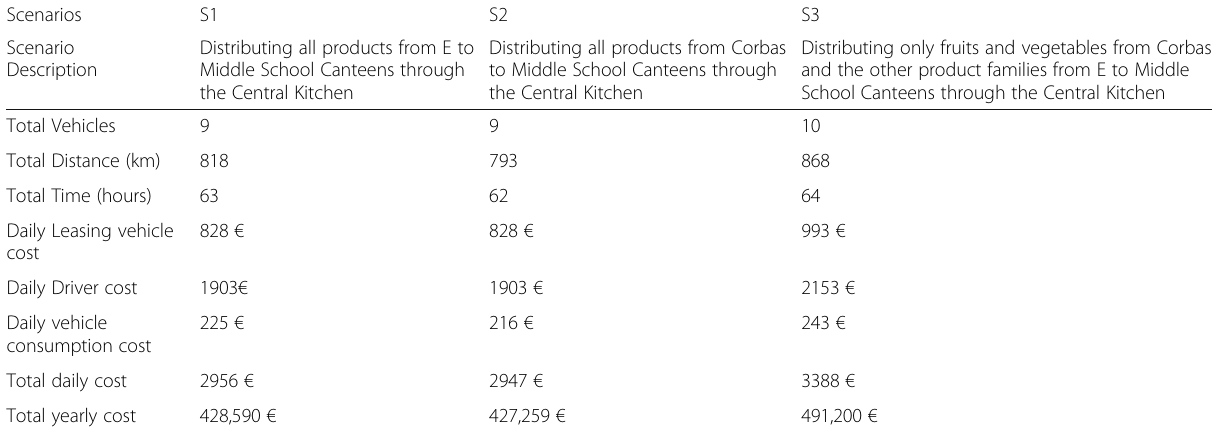
Table 8 The scenarios VRP economic evaluation results for the 3,5 t vehicle calculated according VRP-SS results Scenarios Scenario Description